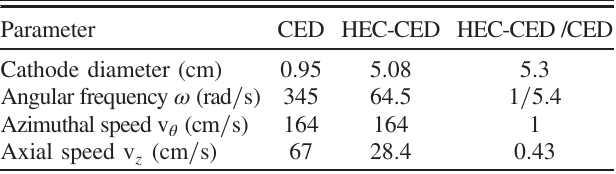
TABLE I. Comparison of parameters in the CED versus HEC-CED